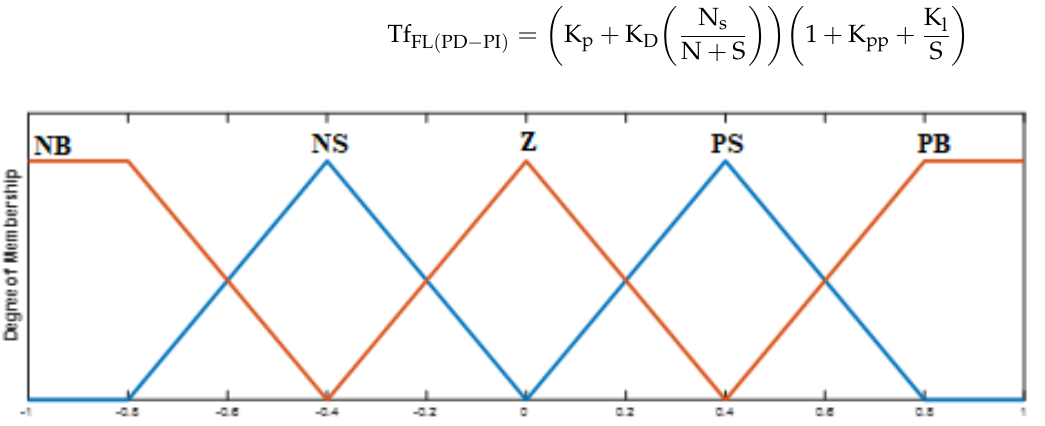
Figure 2. Triangular Memebership Function for FLC.